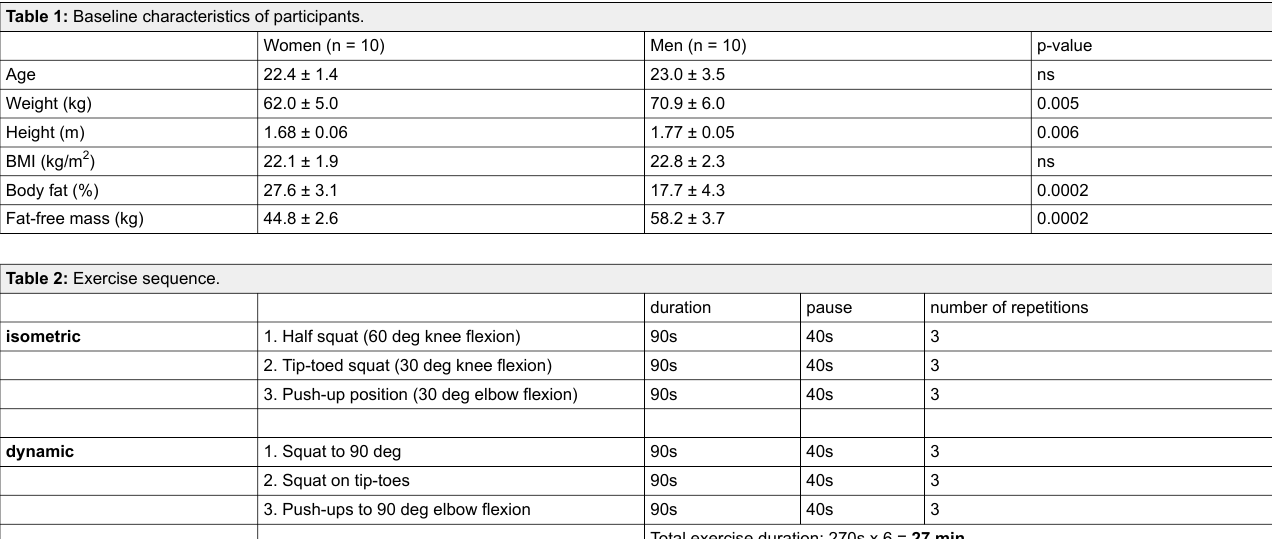
Table 1: Baseline characteristics of participants.